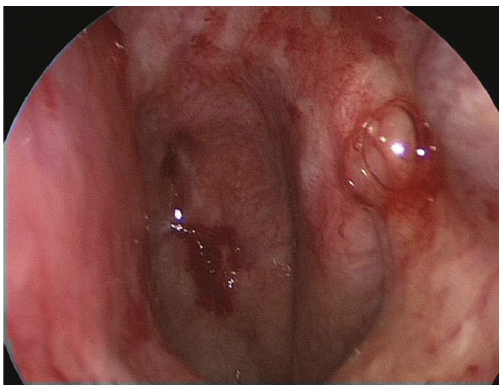
Figure 5: Endoscopic picture of the right nasal cavity with anemic and white nasal